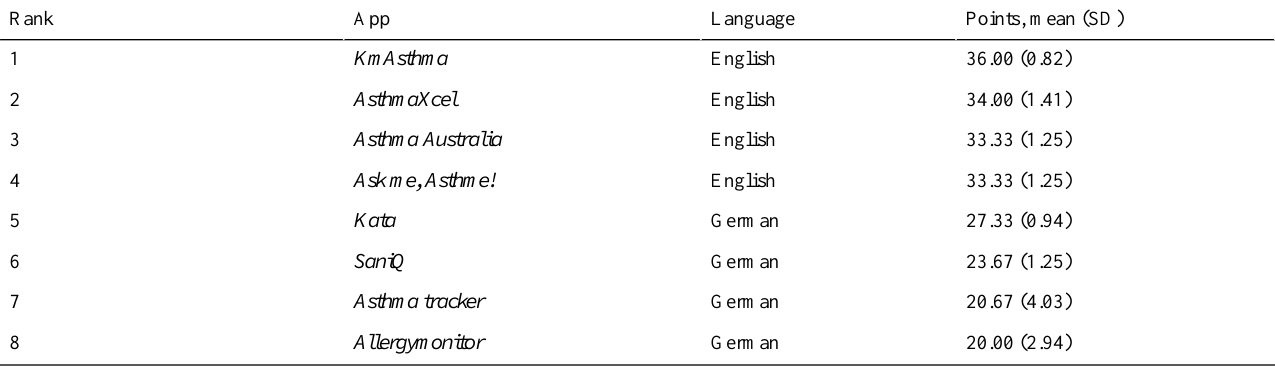
Table 3. Total score of English and German language